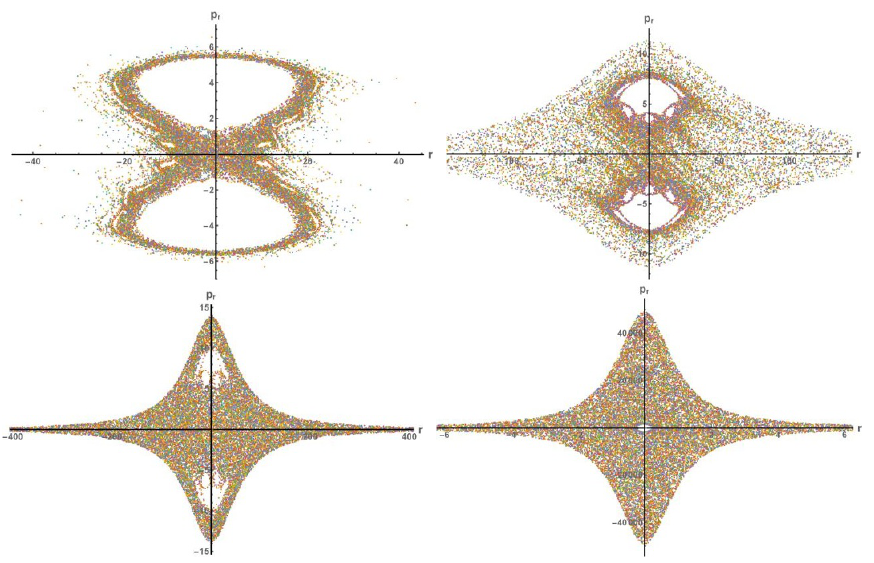
Figure 3 . The Poincar(cid:19)e sections for the (cid:13)avor backreacted theory. The section is chosen such that r ( (cid:28) ) = 0. The constant (cid:20) = 140, the winding number m = 1 and (cid:21)=N c is around unity. The bottom right plot is the Poincar(cid:19)e section for N f =N c (cid:24) 1 where the chaos is obvious. The other three plots from top left to right correspond to N f =N c = 0 : 094 ; 0 : 096 ; 0 : 098. Note that at this limit the range of the validity of the gravity solution is already challenged. However we allow ourselves to push towards this limit to illustrate the formation of chaos.